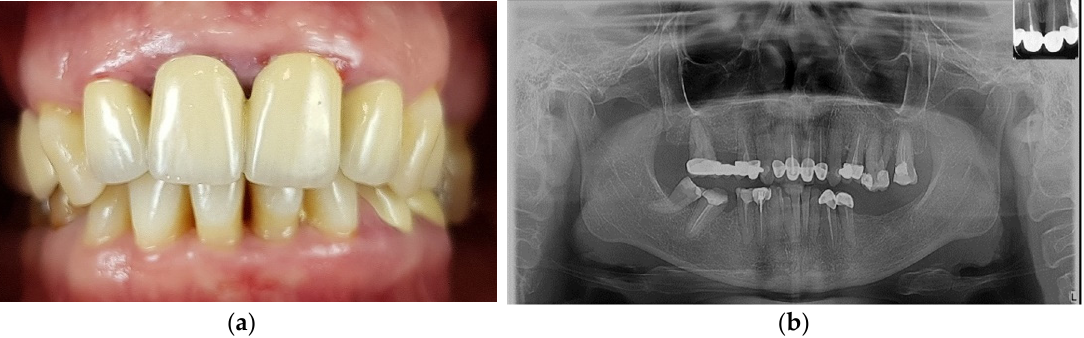
Figure 1. Initial situation of the patient: ( a ) Unaesthetic metal-ceramic crowns with chronic inflam- mation of the gingival margins and oblique interincisal line; ( b ) Initial panoramic X-ray.